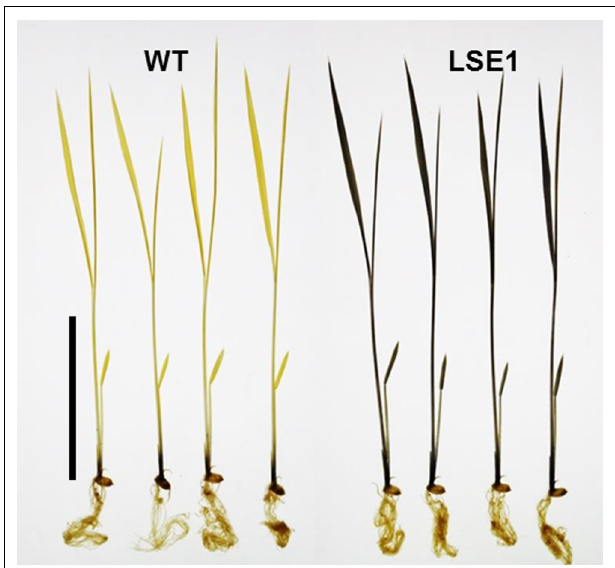
FIGURE 1 | Iodine staining of LSE1 mutant seedlings. Rice seedlings were grown for 14 days and sampled just after the onset of light period. Starch was visualized by iodine staining after the chlorophyll was removed by ethanol. Bar=5cm